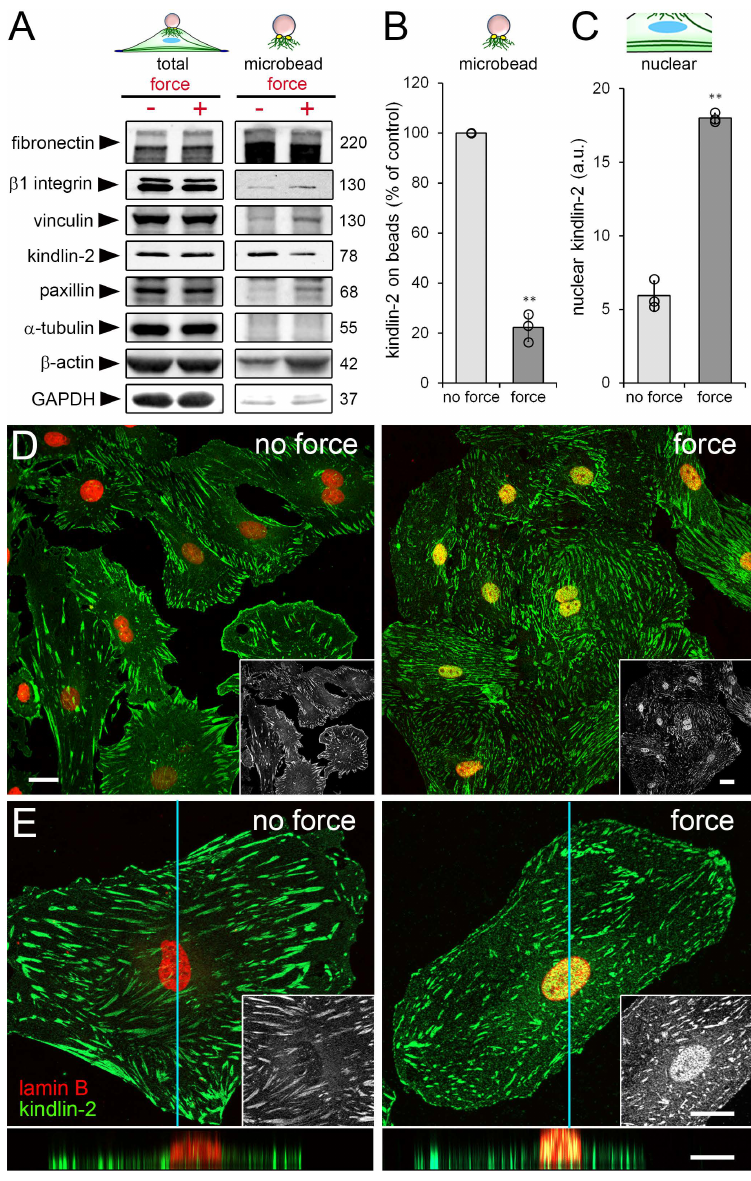
Figure 2. Local application of tensile forces modulates the subcellular localization of kindlin-2. ( A – E ) HCF were incubated with fibronectin-coated magnetic microbeads followed by tensile force application using a magnet. ( A ) Total and microbead-associated cell fractions were collected and analyzed by immunoblotting with indicated molecular weights (glyceraldehyde 3-phosphate dehydrogenase = GAPDH) and ( B , C ) quantified from band intensities. Fibronectin was used as loading control for microbead-associated fractions. ( D , E ) HCF were fixed, permeabilized, stained for kindlin-2 (green) and lamin B (red) and levels of nuclear kindlin-2 (fluorescence intensity, appearing yellow in overlays) were quantified by image analysis. Z-stacks of confocal optical sections were projected into one plane at ( D ) low and ( E ) high magnification. Insets show kindlin-2 staining only, bottom